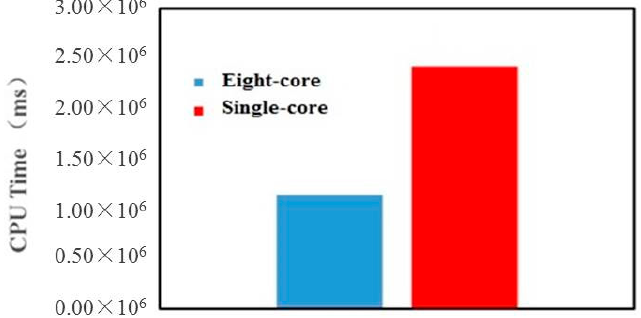
Figure 8. The CPU time of implementing a MCS case in the single-core and eight-core computers.